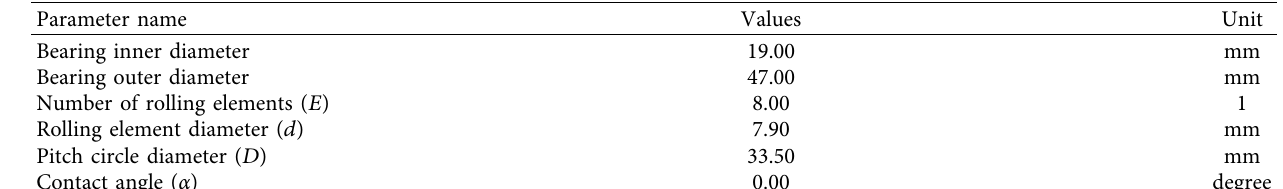
Figure 10: The tested bearings with failure on the outer ring fault. Table 5: Specifications of American ER-12K cylindrical roller bearing with outer ring fault.